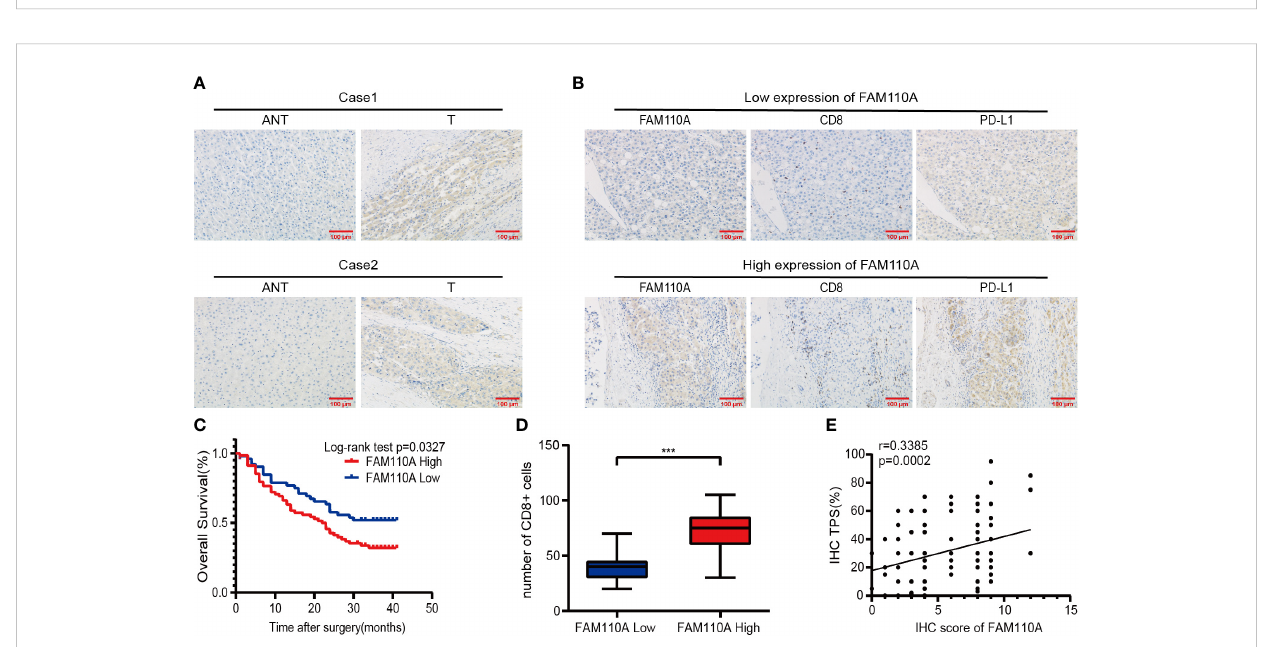
FIGURE 8 FAM110A expression correlated with immune in fi ltration and poor prognosis in LIHC. (A) Representative FAM110A staining image in cancerous and adjacent normal tissues. (B) Representative IHC staining images of LIHC tissues with FAM110A-high and low expression. Positive CD8, PD-L1 expression cells were shown. Scale bars, 100 m m. (C) Kaplan – Meier survival curves for OS of patients with LIHC based on the expression status of FAM110A.*p < 0.05. (D) The number of CD8+ T cells in LIHC tissues with high or low FAM110A expression.***P<0.001. (E) The correlation of FAM110A with PD-L1 protein expression was evaluated by Pearson ’ s